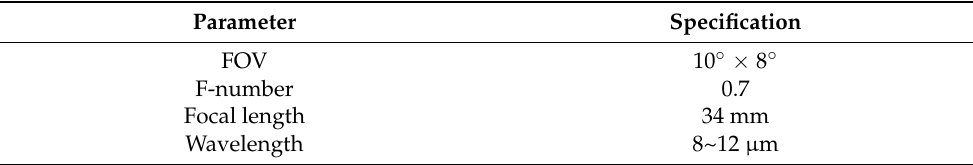
Table 1. System Table 1. System specifications.